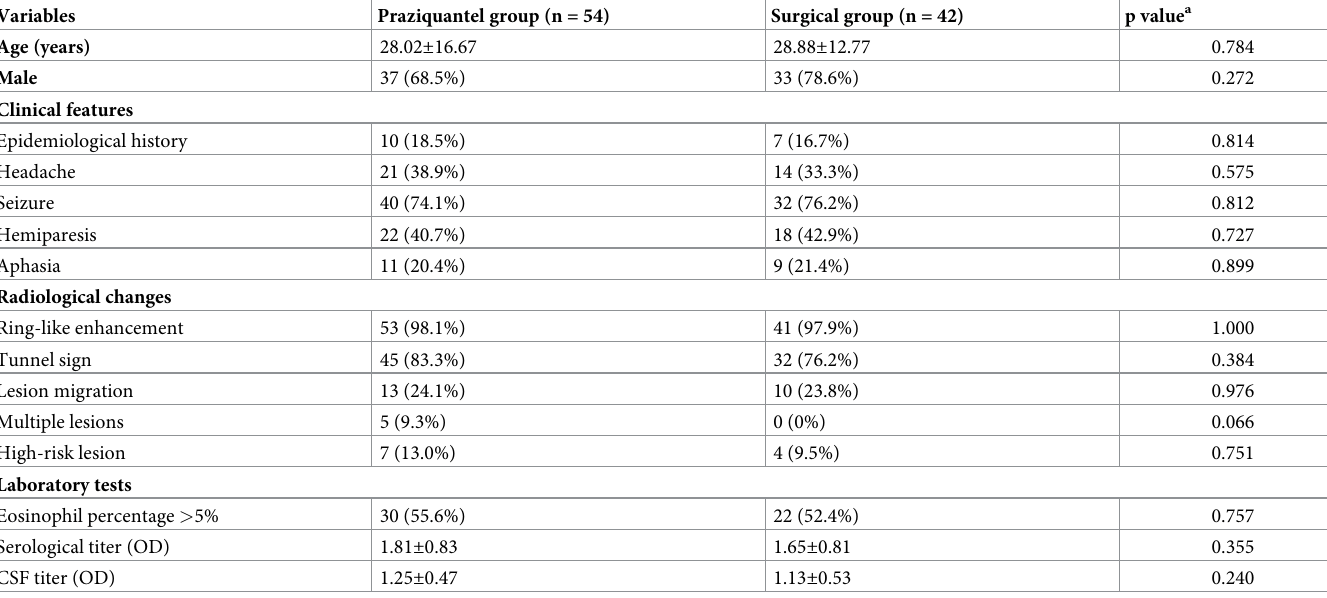
Table 1. Baseline characteristics between the praziquantel and surgical treatment groups.